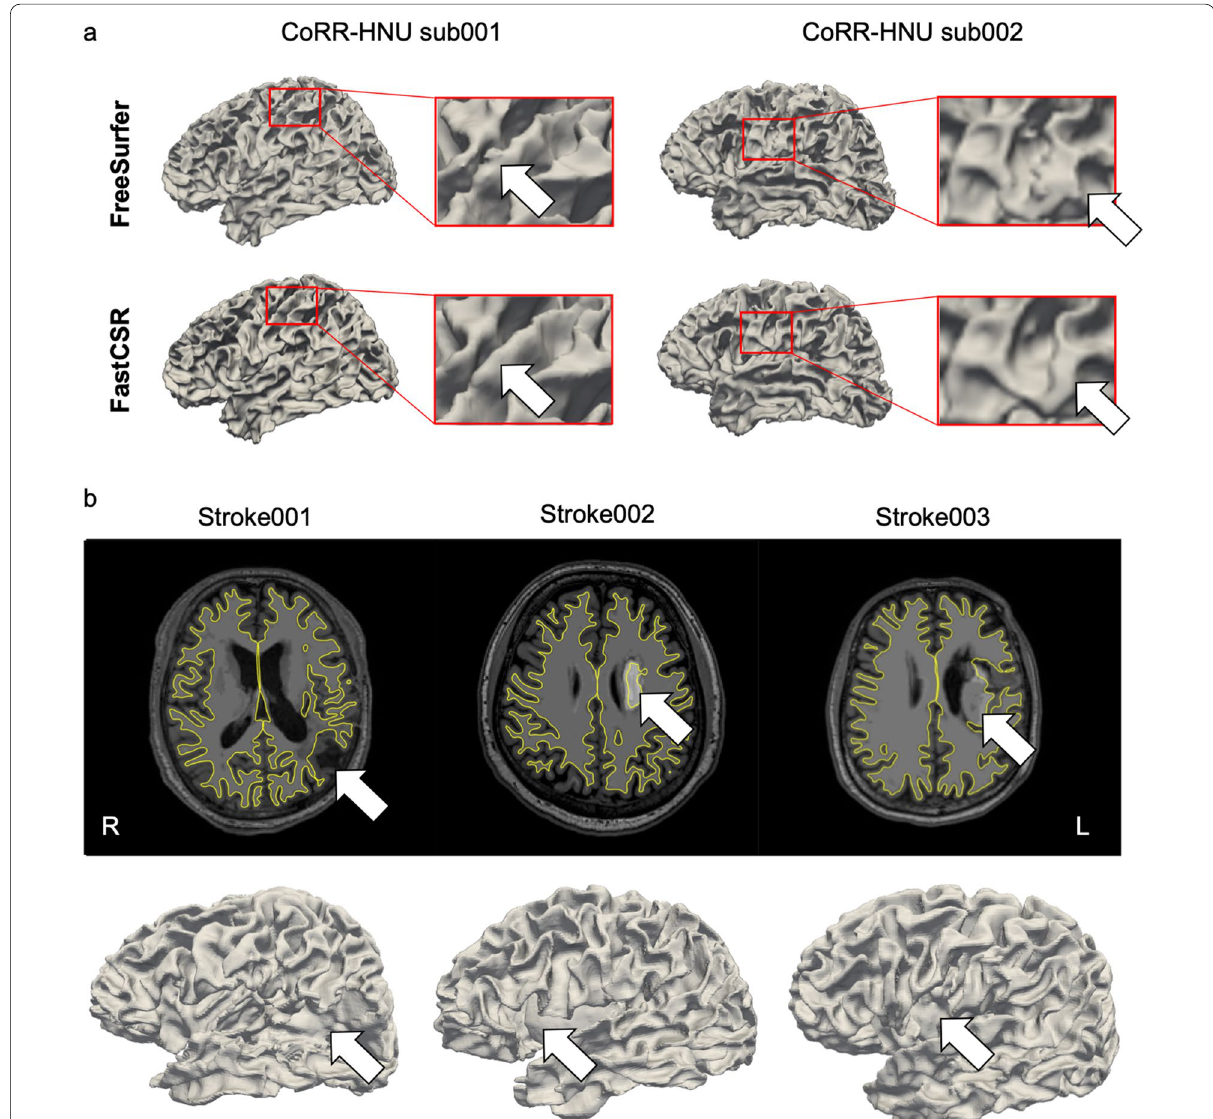
Fig. 9 FastCSR is robust against image quality and brain distortions. a Cortical surfaces of two individuals with poor imaging quality from the CoRR-HNU dataset are reconstructed by FreeSurfer and FastCSR. White arrows highlight the jagged gyri caused by noise in the image (see upper panel) using the FreeSurfer pipeline. Surfaces obtained from the same individuals are reconstructed using our FastCSR method (see lower panel) and yielded cortical surfaces with smoother gyri. b FreeSurfer failed to reconstruct brain surfaces for three stroke patients whose brains are distorted due to lesions, whereas our FastCSR successfully reconstructed the cortical surfaces in these patients. The anatomical boundaries demarcating white matter and pial boundaries (yellow lines) overlaid onto horizontal sections of the T1w images with white arrows indicating the stroke lesions (upper panel). The corresponding cortical surfaces of the lesional hemispheres are displayed (lower panel). The white arrows indicate the